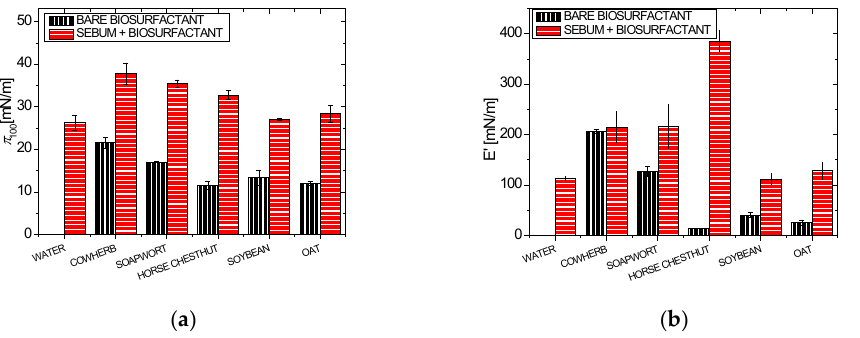
Figure 6. Surface pressure after 100 min, π 100 , ( a ) and surface compression elasticity, E’ , ( b ) for the bare biosurfactants and Milli-Q water (black bars with vertical strips) and the synthetic sebum monolayers in contact with the biosurfactants/ Milli-Q water in the subphase (red bars with horizontal strips). All monolayers were compressed to π 0 = 30 mN/m prior to introduction of the biosurfactants and the final concentration in the subphase was equal to 1%.